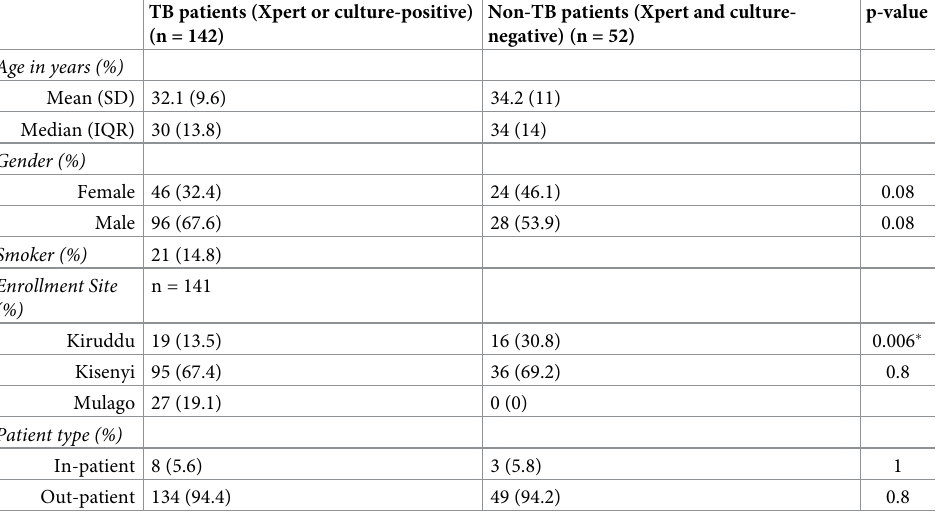
Table 1. Socio-demographic characteristics and other patient